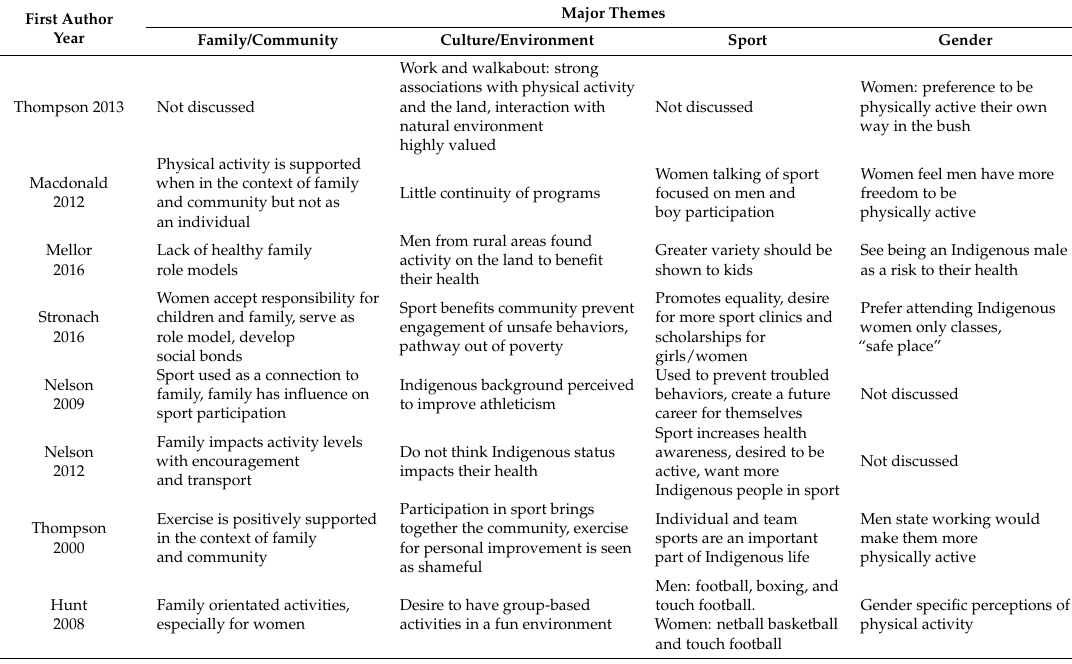
Table 2. Major themes related to physical activity compared across